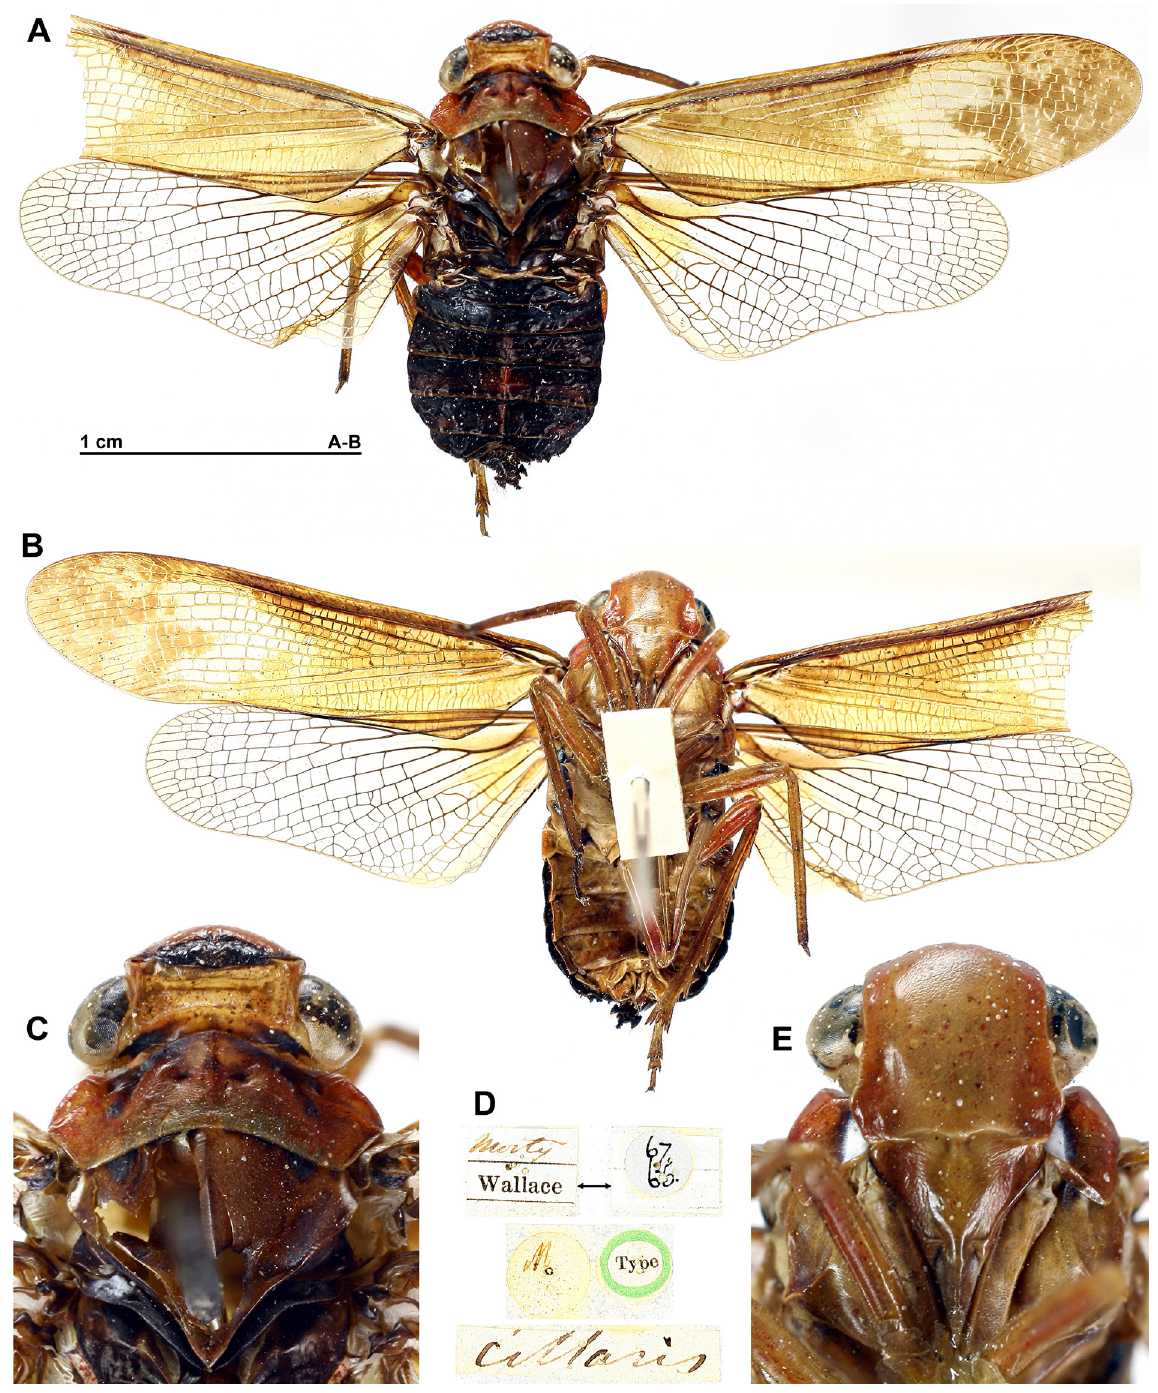
Fig. 4. Birdantis collaris (Walker, 1870), holotype, ♀. A . Habitus, dorsal view. B . Habitus, ventral view. C . Head and thorax, dorsal view. D . Labels. E . Head, normal view of frons. C–E not to